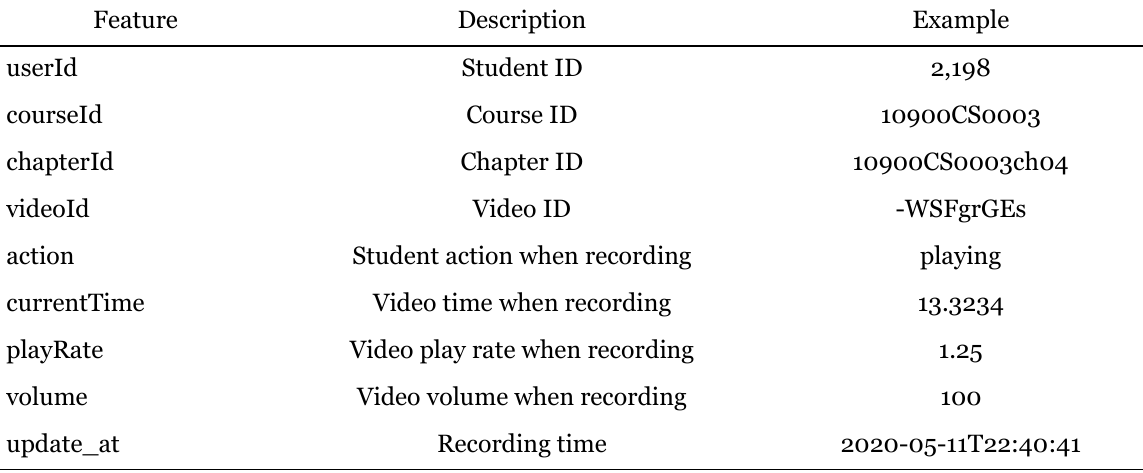
Student Video Activity Schema Feature Description